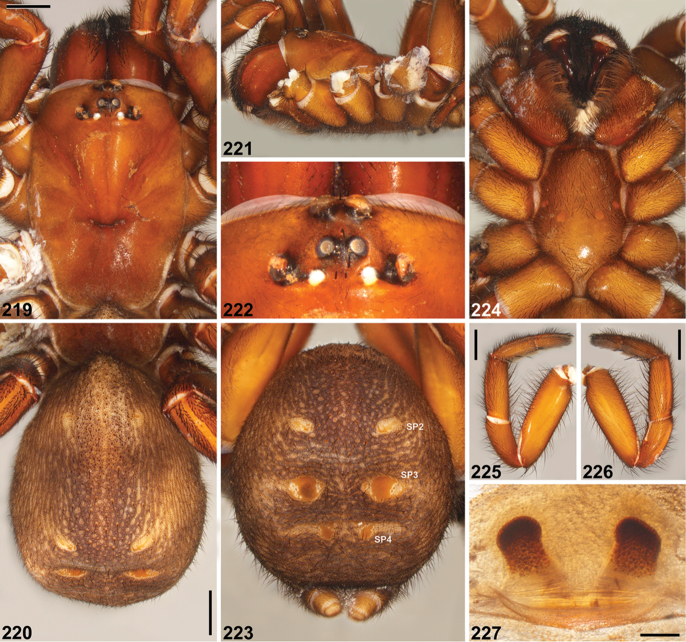

Idiosoma
intermedium sp. n., female (WAM T99749) from SE. of Koolyanobbing (Western Australia; COO). 219–220 Carapace and abdomen, dorsal view 221 Carapace, lateral view 222 Eyes, dorsal view 223 Abdomen, posterior view 224 Sternum, ventral view 225 Leg I, prolateral view 226 Leg I, retrolateral view 227 Spermathecae, dorsal view. Scale bars 2.0 (219–220, 225–226), 0.5 (227). SP2–4 = sigilla pairs 2–4.